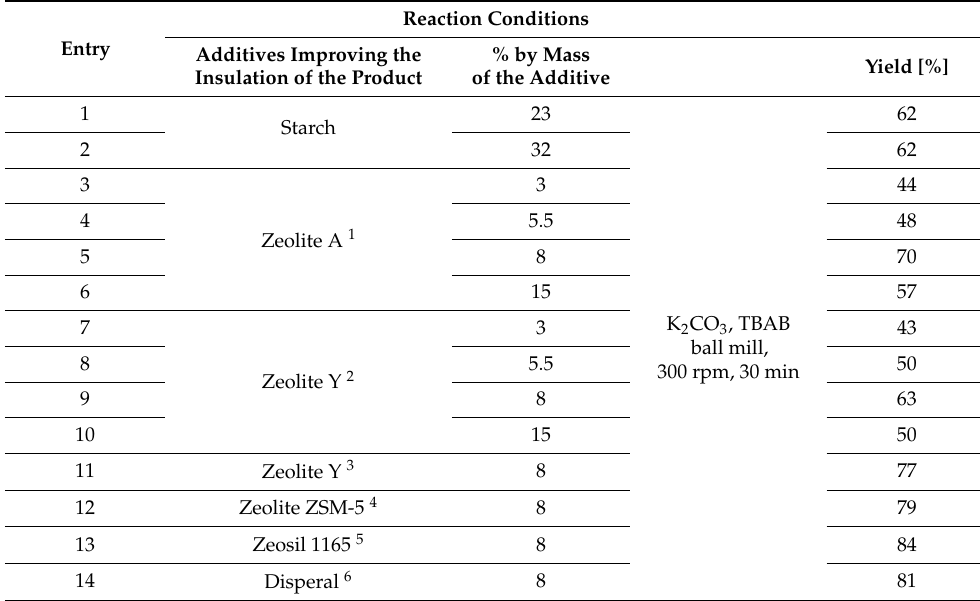
Table 3. Synthesis of aripiprazole in the presence of potassium carbonate, TBAB and additives improving the insulation of the product in a ball mill (rotation speed 300 rpm, stainless steel balls with a size Ø10 mm, Planetary Ball Mill PM 100-RETSCH). The molar ratio Ia : IIa :K 2 CO 3 :TBAB